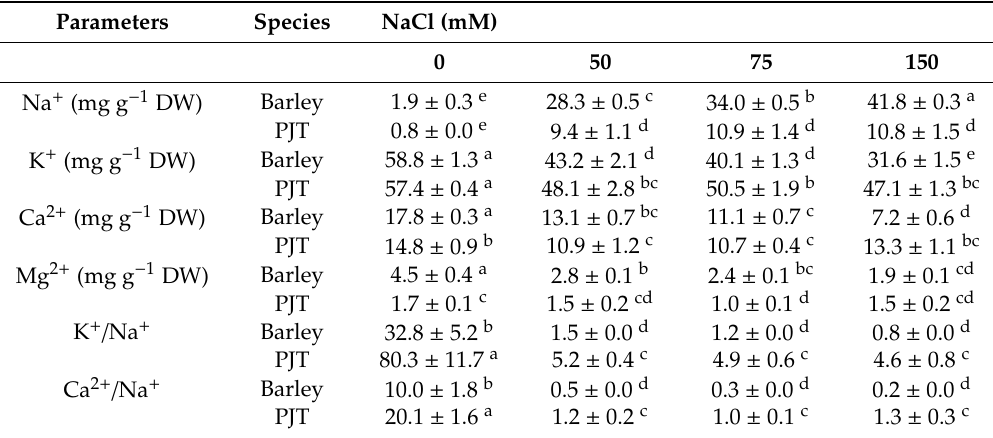
Table 2. Cation concentrations and K + / Na + and Ca 2 + / Na + ratios in barley and Peucedanum japonicum (PJT) leaves at di ff erent NaCl